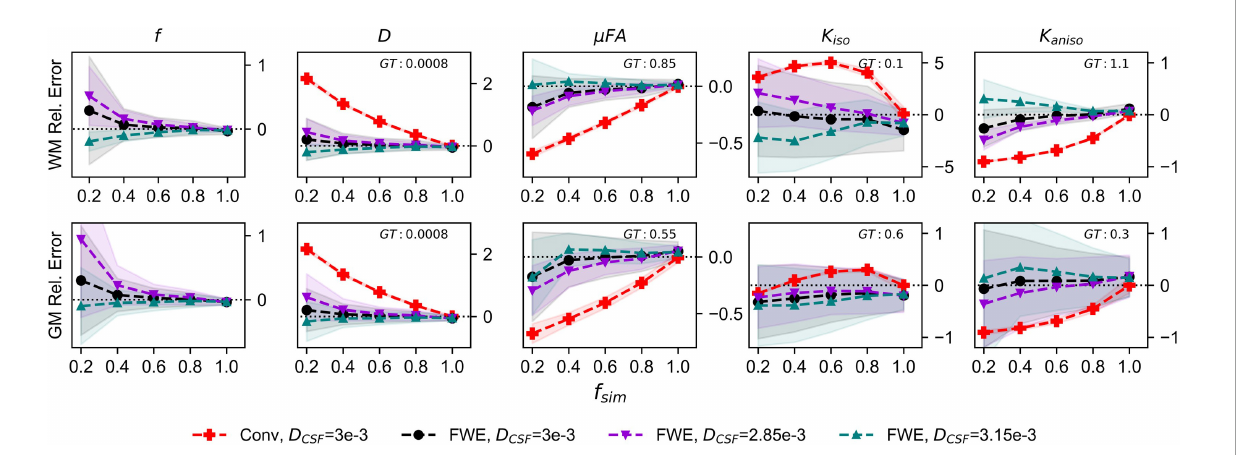
FIGURE3 Relative error in diffusion MRI indices measured in synthetic white matter (WM) and gray matter (GM) voxels with various free water diffusivities ( D CSF ) and an SNR of 20. The x -axis depicts the simulated volume fraction ( f sim ), while the ground truth value for each metric is denoted as GT. The red line with crosses indicates the mean measurements made using the conventional (Conv) method with D CSF = 3 e − 3 mm 2 / s , the black line with circles depicts the FWE method with D CSF = 3 e − 3 mm 2 / s , the purple line with inverted triangles depicts the FWE method with D CSF = 2 . 85 e − 3 mm 2 / s , and the teal line with triangles depicts the FWE method with D CSF = 3 . 15 e − 3 mm 2 / s .